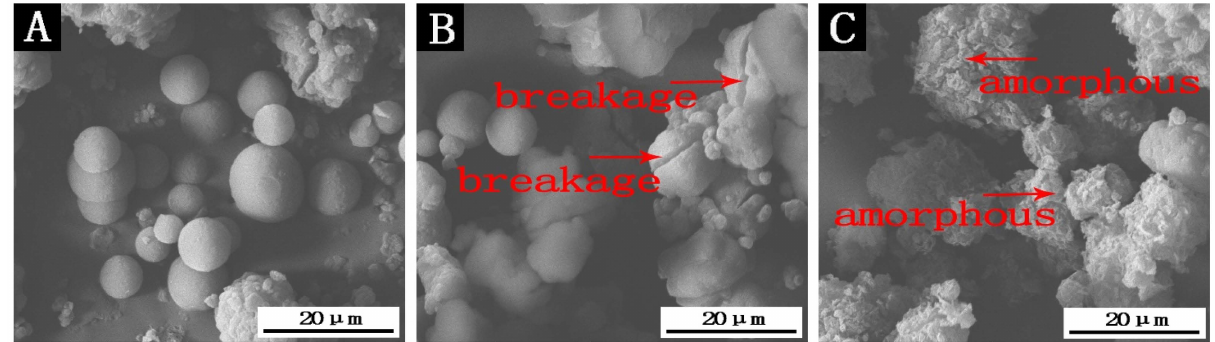
Figure 1. SEM images of microcapsules with different core to wall ratios: ( A ) 0.033, ( B ) 0.100, and ( C ) 0.167.